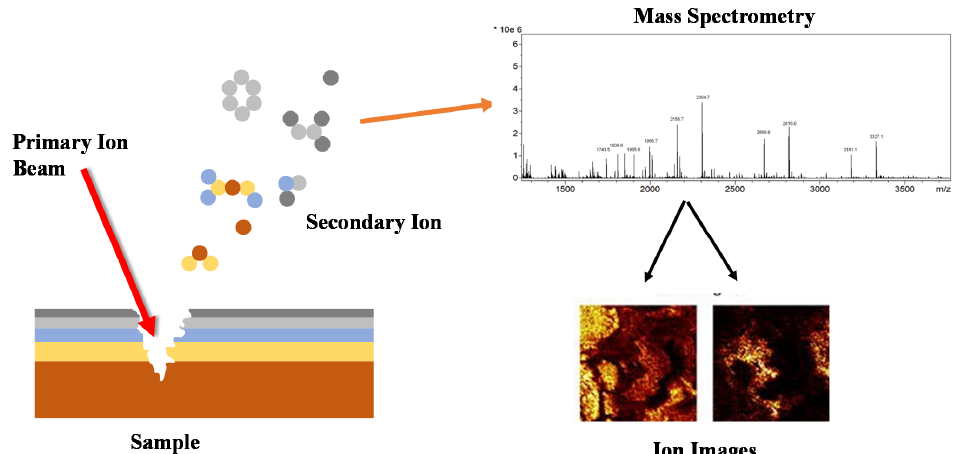
Figure 4. Schematic illustration of a dynamic secondary ion mass spectrometer (SIMS). An ion gun supplies a high energy ion beam (several keV) on the surface of a target biofilm. This results in ionization of the surface and sputters some of the atoms. These atoms will be collected by ion lenses and separated according to their atomic mass. Finally, the ions are exposed to an electron multiplayer or a Faraday cup.